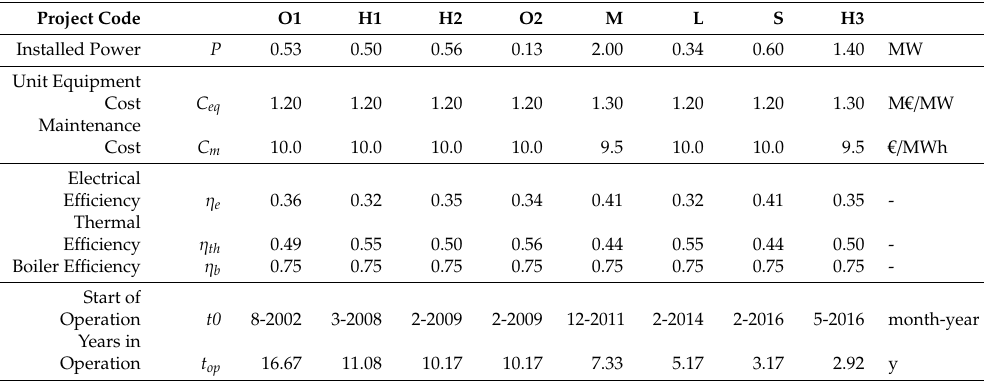
Table 1. Characteristics of the examined CHP projects in operation, 2019, Athens, Greece.